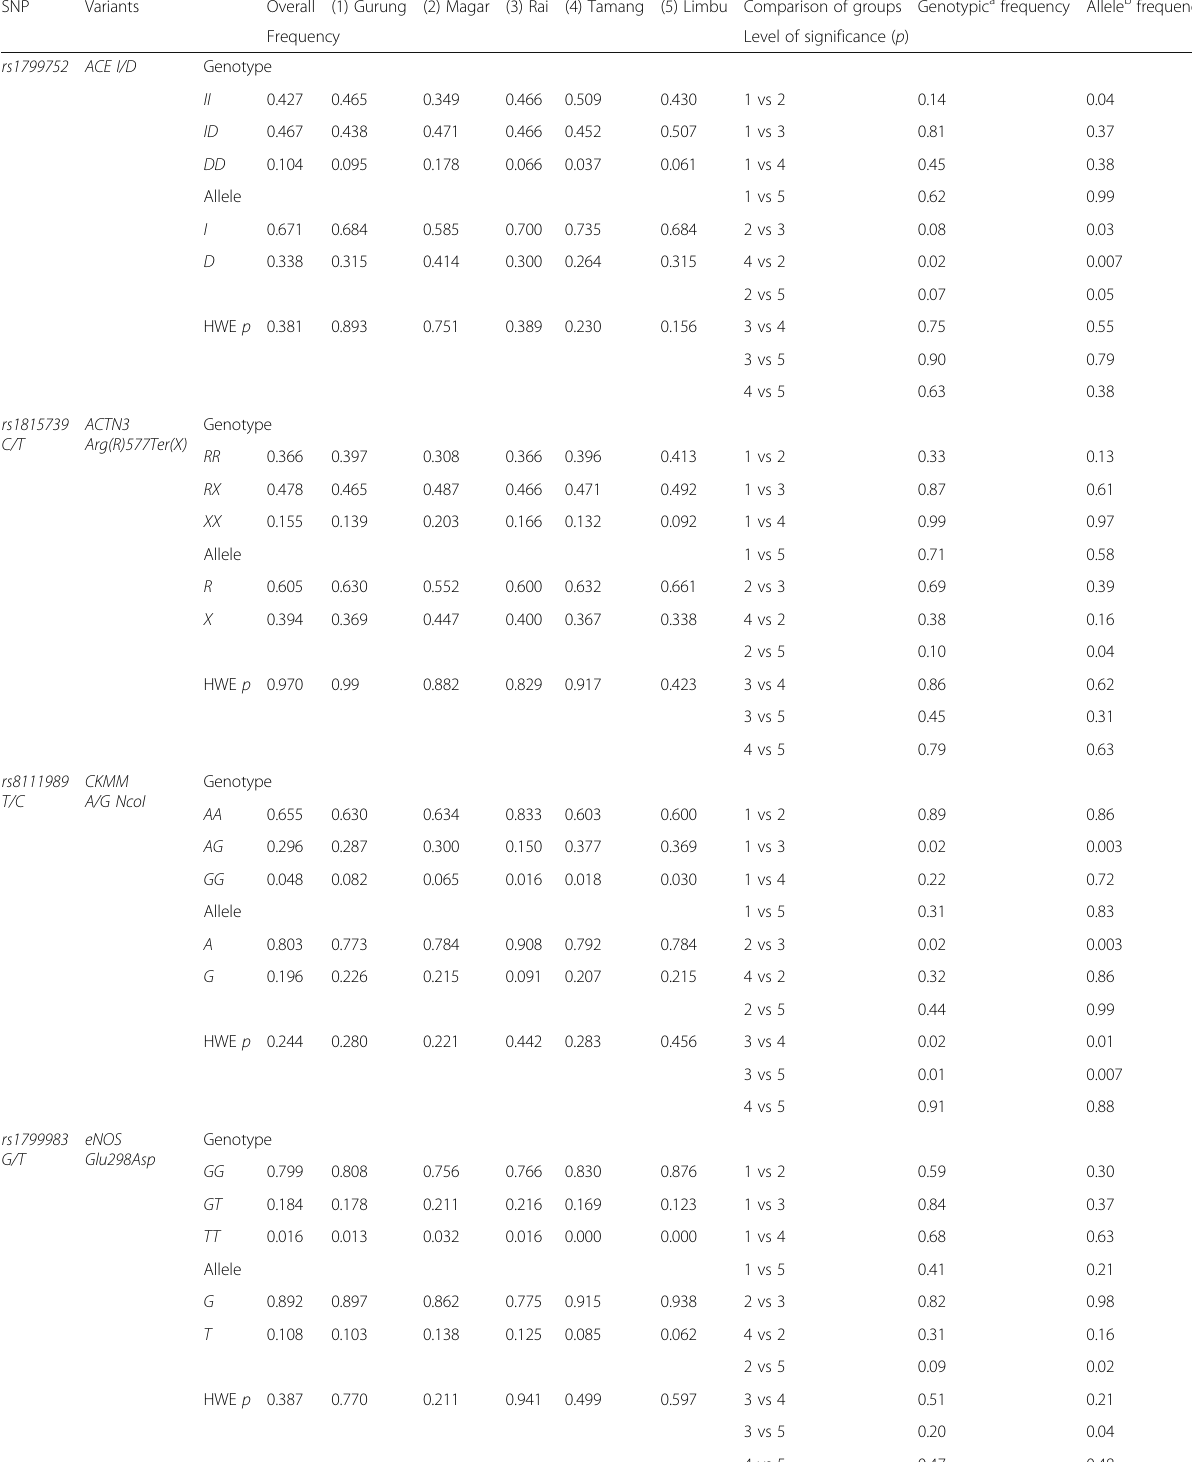
Table 5 Frequency distribution of the polymorphisms in the male Gorkha soldiers (Tibeto-Burman) SNP